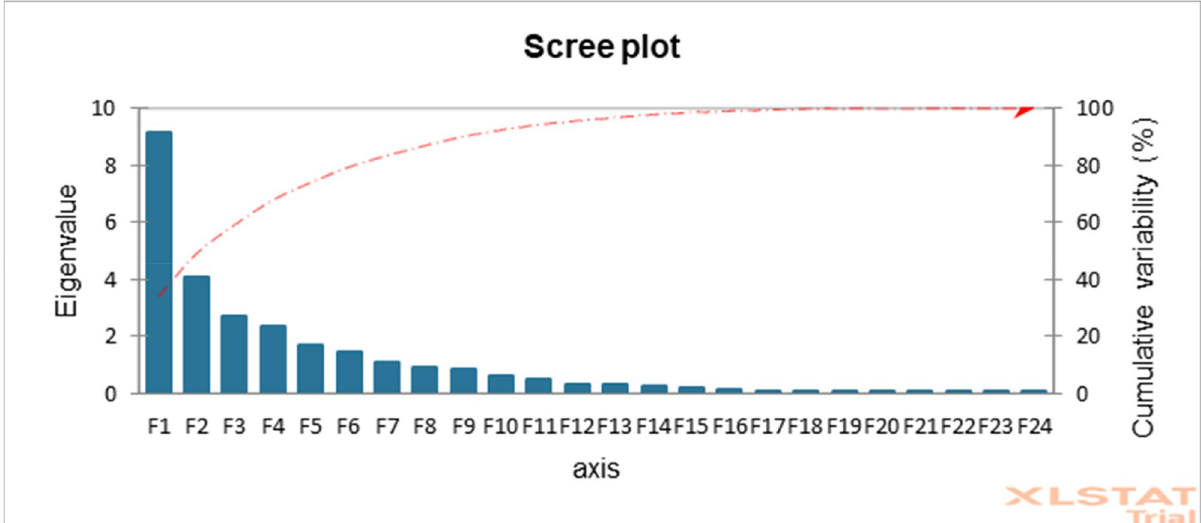
Figure 5. Graphical illustration of eigen values, axis, and % cumulative variation revealed by XLSTAT.